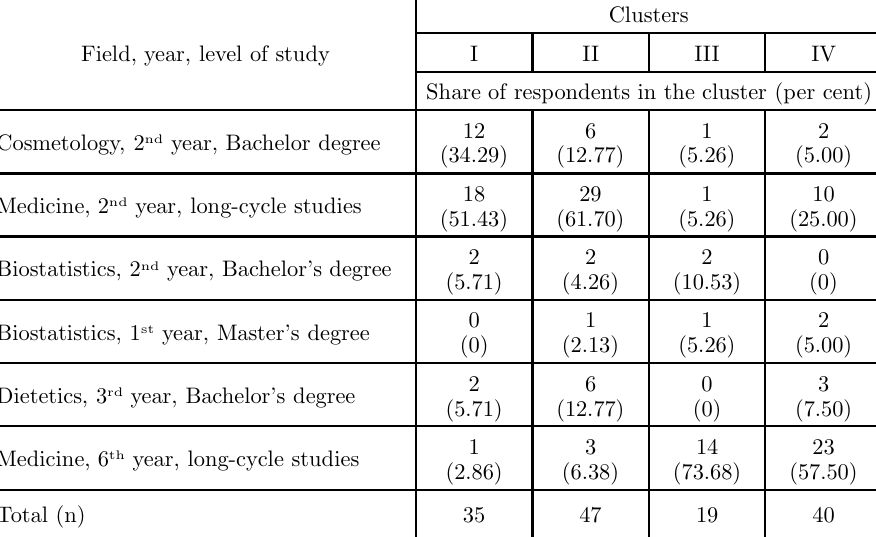
Table 1. Cluster characteristics obtained with Kohonen Networks